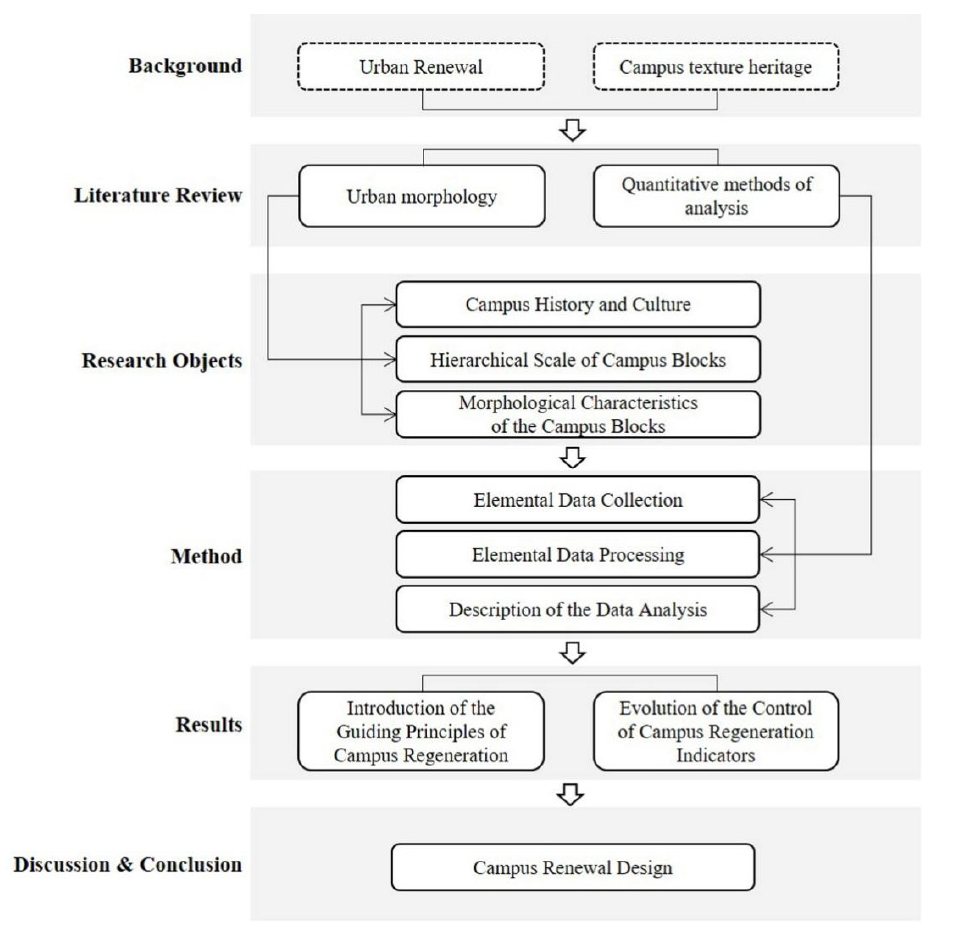
Figure 2. Research framework and process.